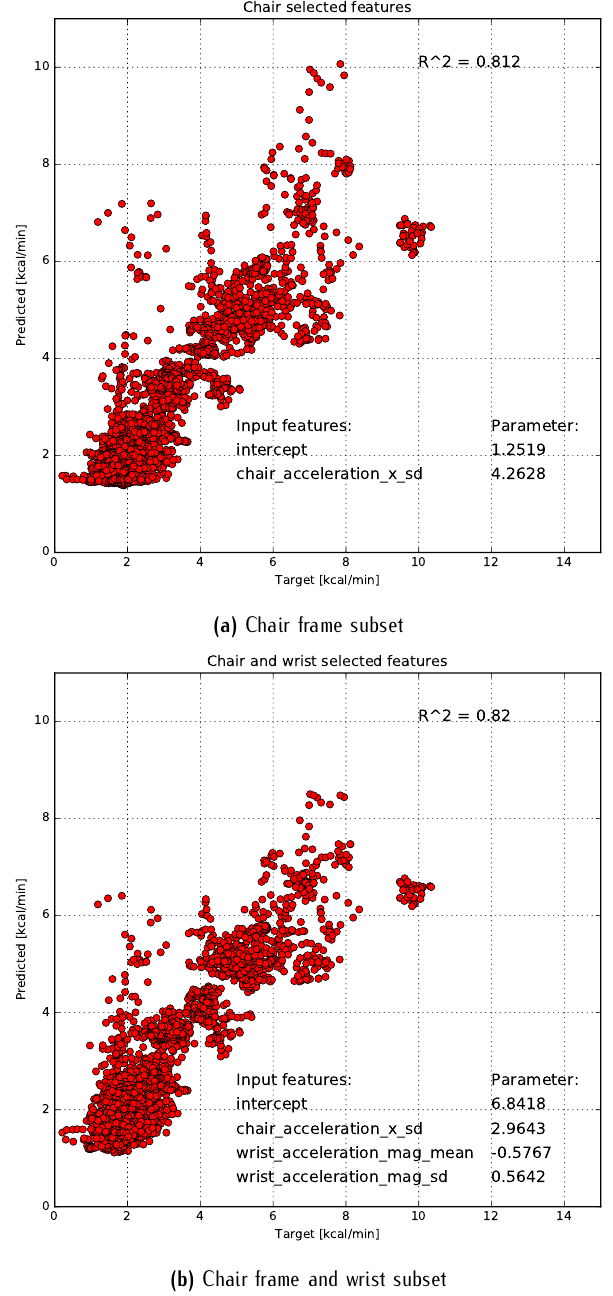
Figure 7. Results of the models created after undergoing the feature selection process. The R 2 values shown were computed using